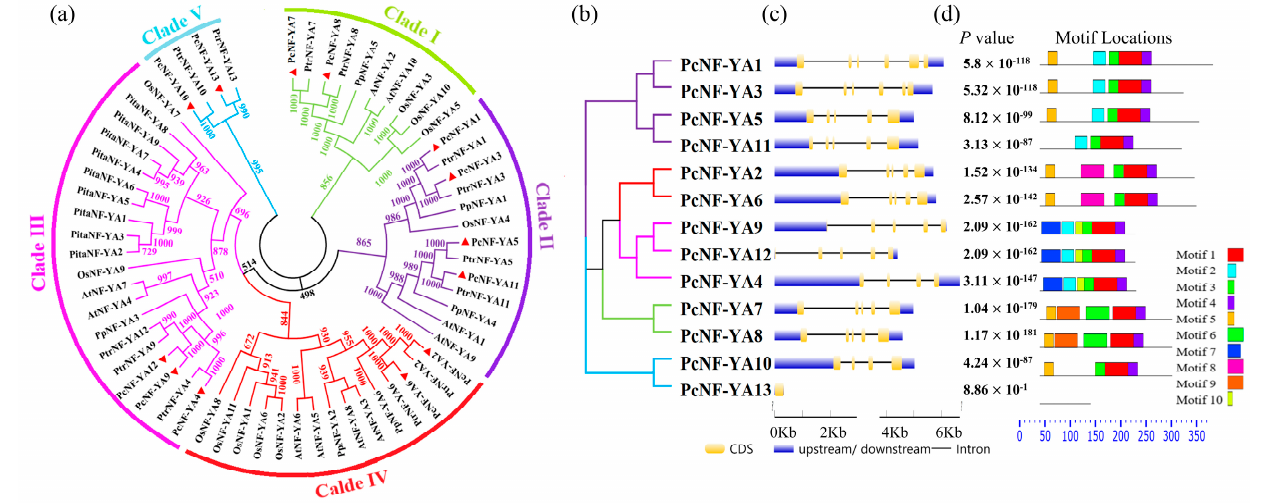
Figure 1. Phylogenetic, gene structure and protein motif analyses of NF-YA proteins in P. × canescens. P. × canescens (Pc), P. trichocarpa (Ptr), A. thaliana (At), O. sativa (Os), Pinus tabuliformis ( Pita ) and Prunus persica L (Pp). Green, purple, pink, red and blue branches represent Clades I, II, III, IV and V, respectively. ( a ) PcNF-YA proteins are marked with red filled triangles. ( b ) The amino acid sequences of PcNF-YAs were used to create a phylogenetic tree with the neighbor-joining (NJ) method. Bootstrap = 1000. Clades I to V are displayed with different colors. ( c ) The intron/exon structures of the PcNF-YA family. Blue rectangles, yellow rectangles and black lines indicate UTRs, exons and introns, respectively. ( d ) Conserved motif analysis of PcNF-YA proteins. Conserved motifs shown in different colored boxes were created by MEME, and sequence information for each motif is provided in Additional file Table S2. The scales at the bottom in ( c , d ) represent the sequence lengths.